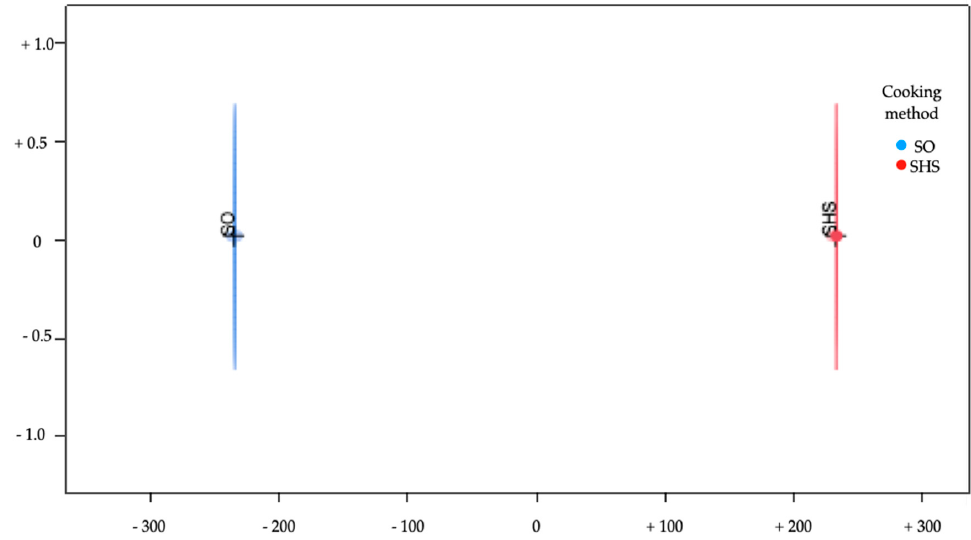
Figure 1. Discriminant diagram. Table 7. Scores of canonical 1 .